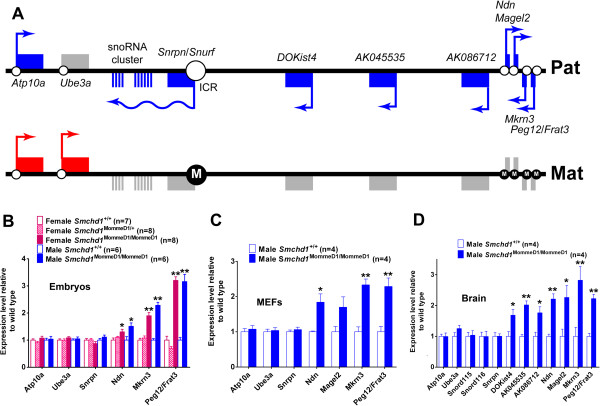
A subset of imprinted genes in the Snrpn cluster shows increased expression in Smchd1 mutants. (A) The Snrpn imprinted gene cluster, where those genes expressed from the paternal allele are shown in blue and those expressed from the maternal allele are in red. CpG islands are represented by circles on the line and where these represent an sDMR (small circles) or imprint control region (ICR) (large circle) the methylation status is indicated (M inside the filled circle for the methylated allele or unfilled circle for the unmethylated allele). Quantification of the expression levels of imprinted genes or transcripts within the Snrpn cluster by qRT-PCR measured using RNA derived from: (B) male and female E9.5 embryos, (C) mouse embryonic fibroblasts (MEF) derived from male E14.5 embryos, and (D) whole brain from adult male mice. The synthesis of first-strand cDNA from E9.5 embryo RNA was primed with oligo dT, but for the analysis of transcript levels in MEFs and brain the cDNA synthesis was primed with a cocktail of the reverse primers used for qRT-PCR. In each case the qRT-PCR signal was normalized relative to that of Rala and plotted relative to the corresponding Smchd1+/+ sample. The genotype, sex, and number of replicates are indicated in each case. Statistical analysis was performed using the t test. ** P < 0.01 and * P < 0.05 compared with wildtype. Error bars indicate standard error.